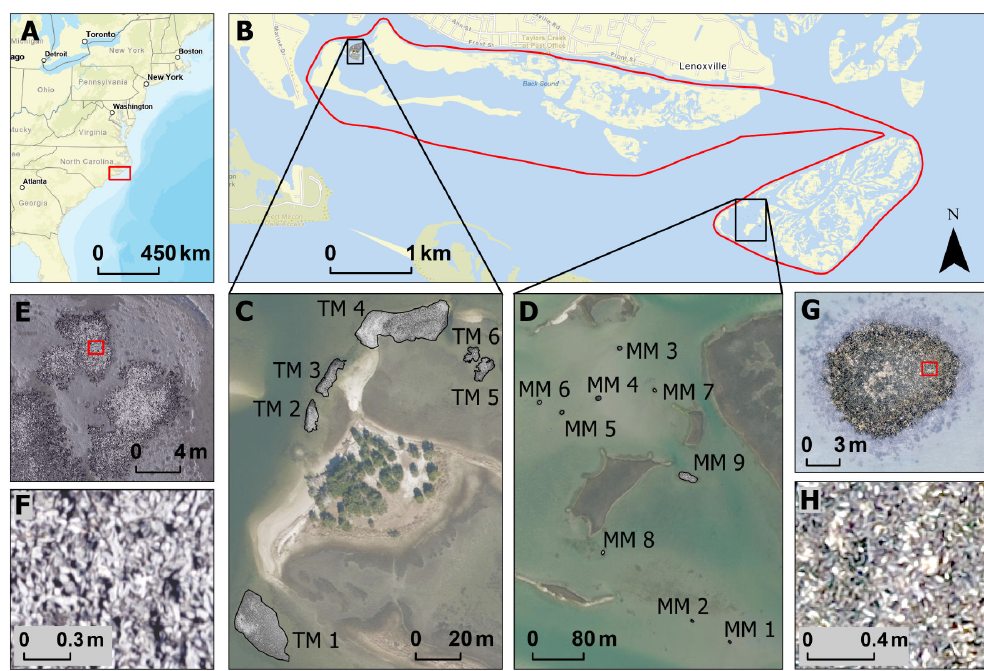
Figure 1. ( A ) Location of study area in eastern North Carolina, USA, ( B ) Boundary of the Rachel Carson NERR, Beaufort, NC, ( C ) Natural fringing intertidal oyster reefs located at Town Marsh (labeled and outlined in black), ( D ) Natural and restored intertidal patch reefs located at Middle Marsh (labeled and outlined in black), ( E ) UAS imagery showing patch reefs at Town Marsh (TM 5, TM 6, and TM 2), ( F ) Zoomed in UAS image of TM 6, ( G ) UAS imagery showing patch reefs at Middle Marsh (MM 3), ( H ) Zoomed in UAS image of MM